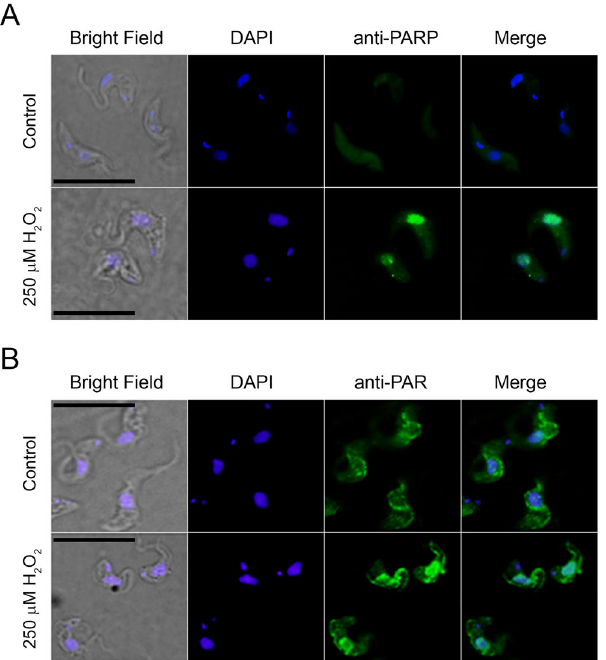
Figure 6. Tb PARP ( A ) and PAR ( B ) localization was detected with anti- Tb PARP and anti-PAR polyclonal antibodies, respectively, in wild type bloodstream parasites. DAPI was used to identify nuclear and kinetoplastid DNA. Merge panels show that both Tb PARP and PAR are localized to the nucleus upon hydrogen peroxide treatment. Bar: 5 µ